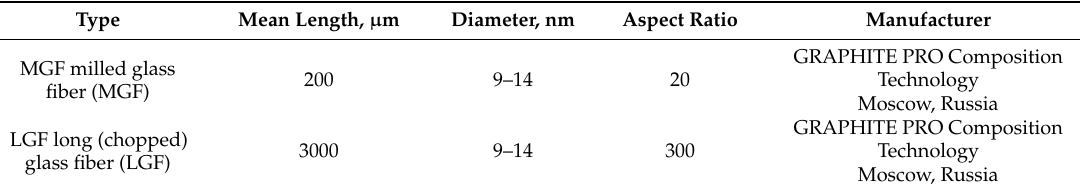
Figure 1. SEM micrographs of the Ultra High Molecular weight Polyethylene UHMWPE powders: GUR 2122 ( a ); GUR 4120 ( b ); GUR 4022-6 ( c ). Table 2. Fibrous fillers used for the composite fabrication.